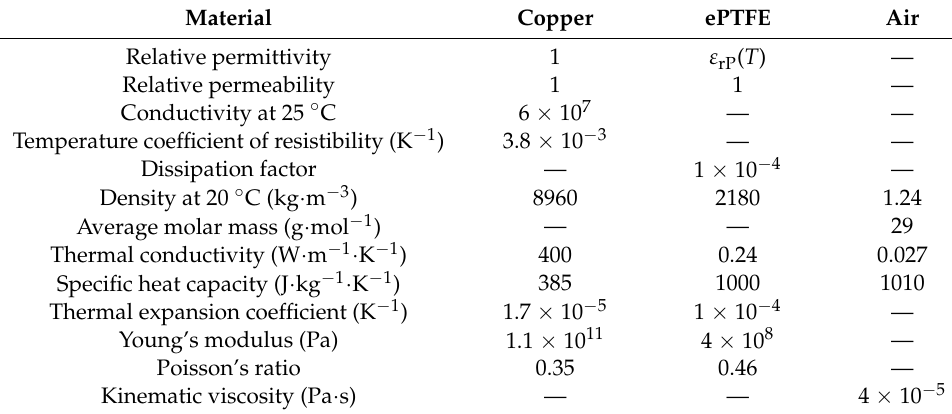
Table 2. Material Properties.